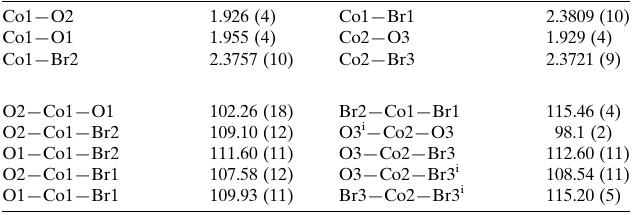
Selected geometric parameters (A˚ , (cid:3)